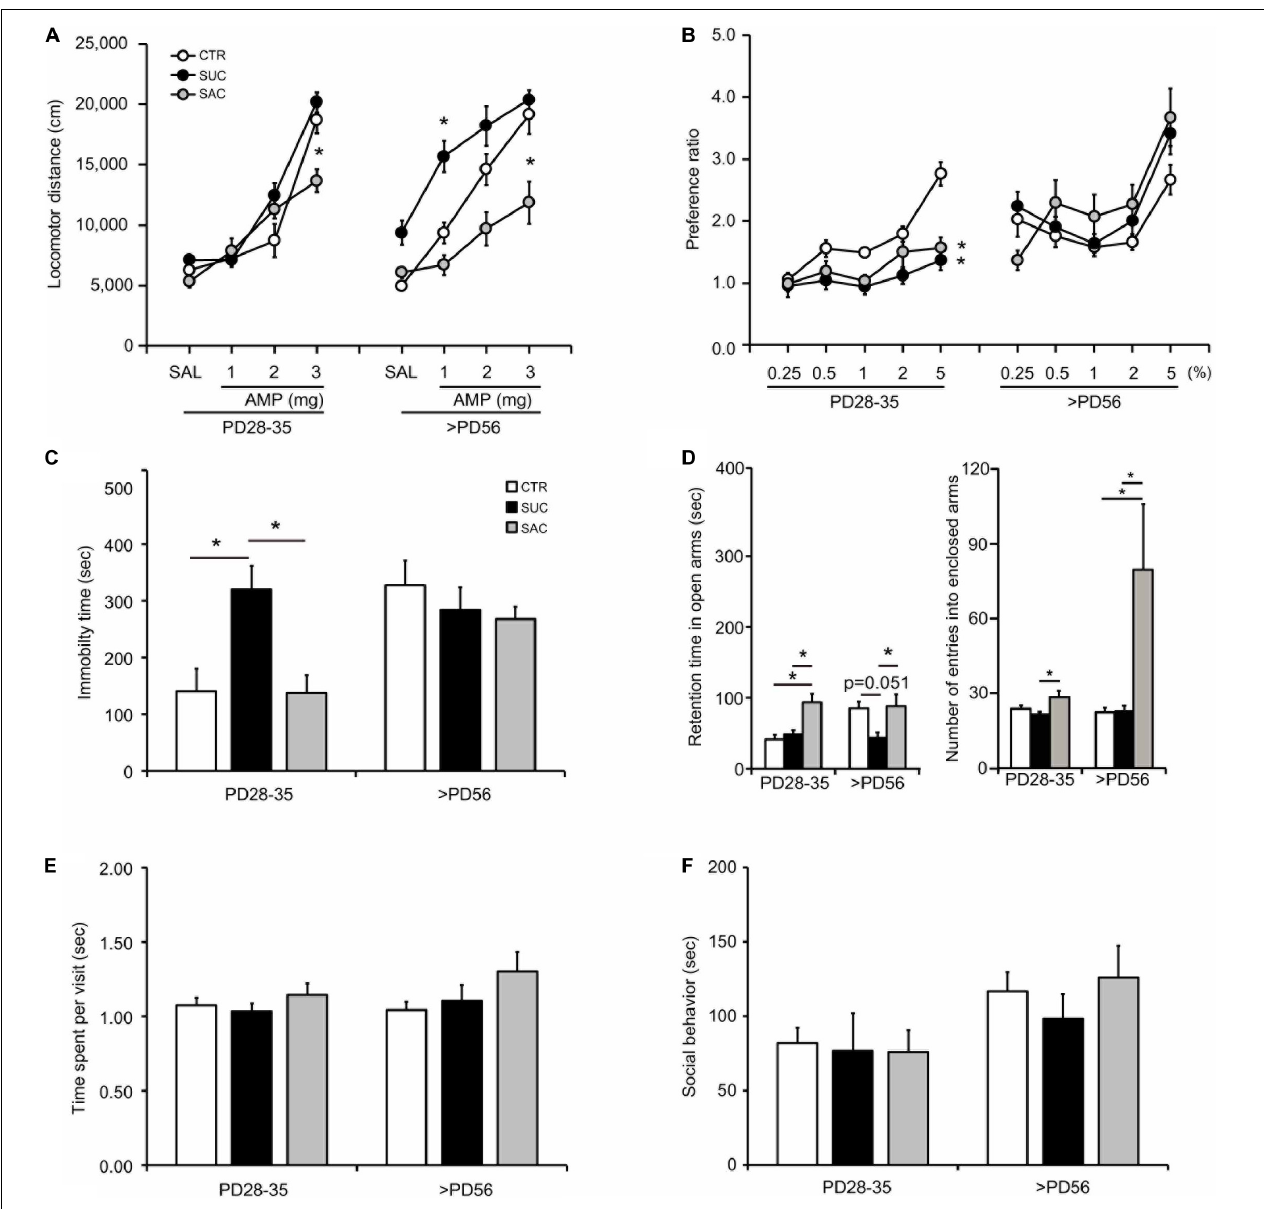
FIGURE 2 | Behavioral alterations in animals subjected to sucrose and saccharine treatments. (A) Graph showing amphetamine (AMP) modulation of locomotion in juvenile (PD28–35) and adult ( > PD56) animals. (B) Graph showing sucrose preference expressed as the ratio of sucrose solution intake over tap water intake in the sucrose preference test. (C) Graph showing the duration of immobility in the forced swimming test. (D) Graph showing the time spent in the open arms (left) and the number of entries into the enclosed arms (right) in the elevated plus maze. (E) Graph showing the time spent for object exploration per visit in the object exploration test. (F) Graph showing the time spent on social interaction with a mate in the social interaction test. * p < 0.05.